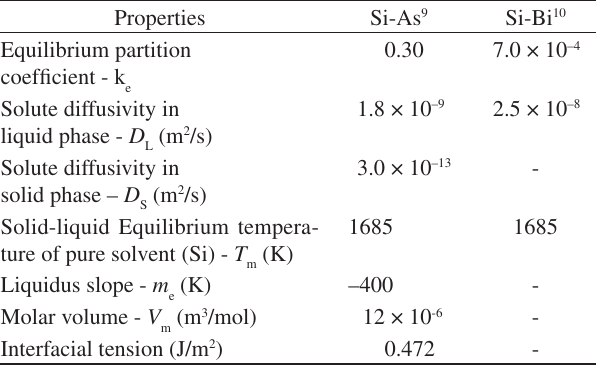
Table 2. Data used to predict the effect of solidification velocity on solute partition coefficient